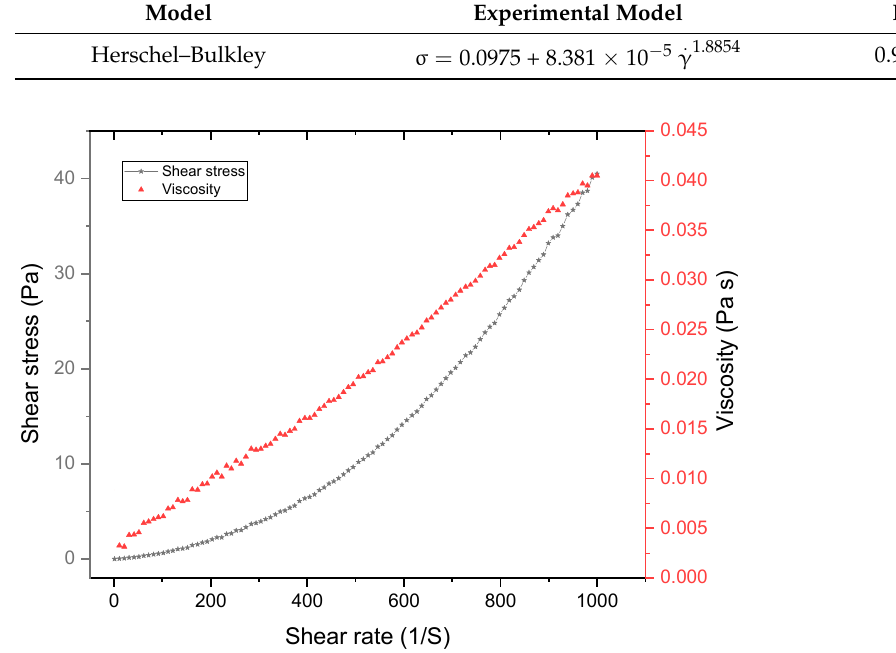
Figure 1. Rheological behavior of fermented mash at 25 °C.